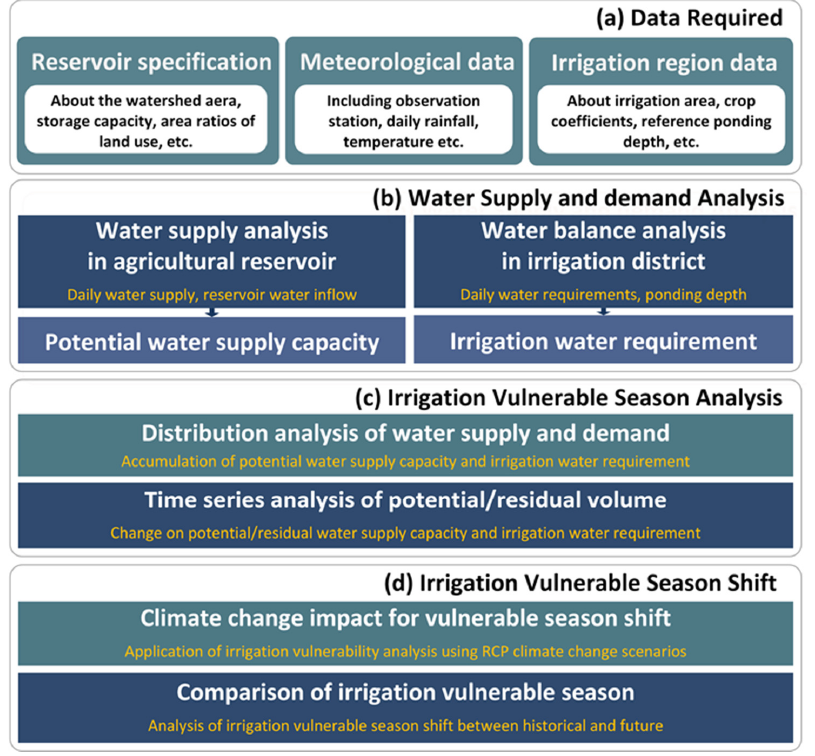
Figure 2. Schematic diagram of the assessment for vulnerable seasons of paddy irrigation.